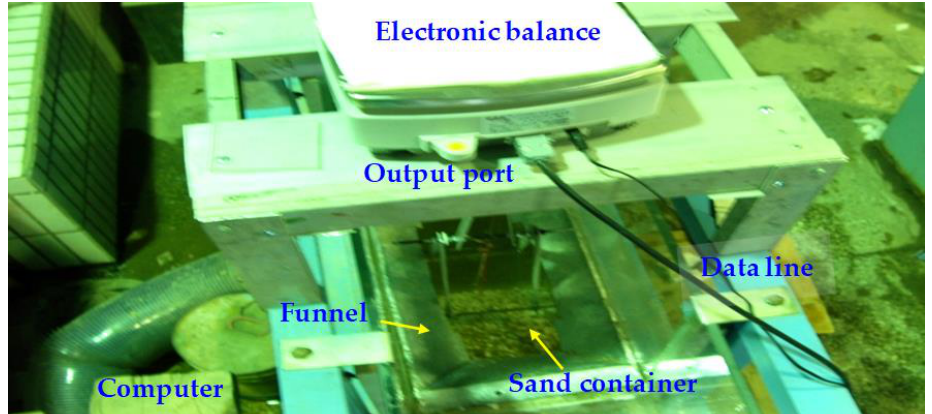
Figure 4. Automatic measurement system (SMTM) of bed load. The system was located at the end of the flume and was composed of the electronic balance, sand container, and computer, etc. The transported bed load sediments were weighed instantly as they fell into the sand container, and the weight data of the sediment were also transferred to the computer